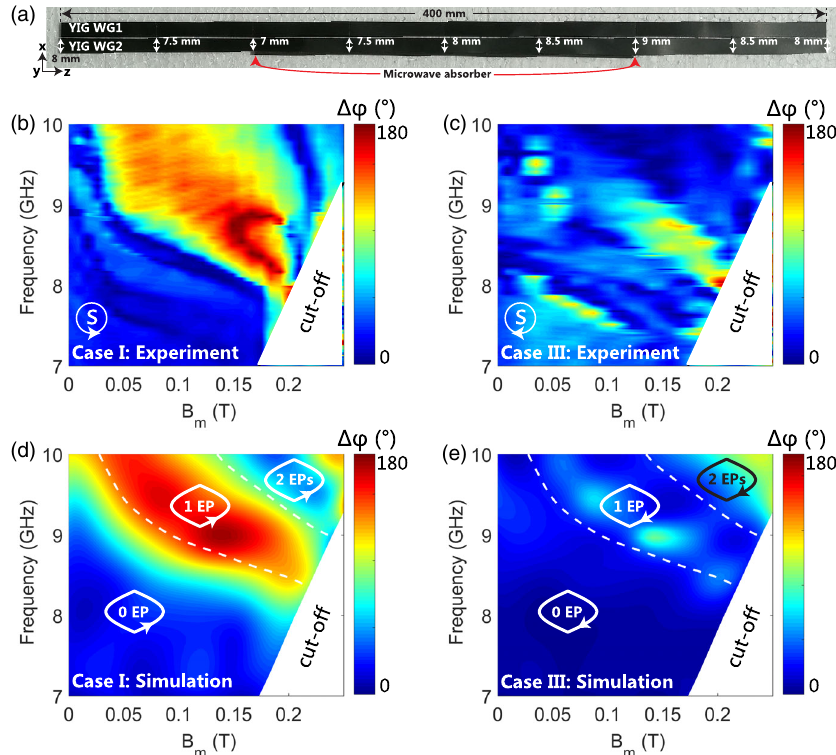
FIG. 5. (a) A photograph of the fabricated coupled YIG waveguides. Waveguide-1 measures W × H × L ¼ 8 × 4 × 400 mm, while waveguide-2 measures α ð z Þ W × H × L with the profile of α ð z Þ shown in Fig. 2(d). The gap distance is g ≈ 0 . 5 mm. Microwave absorbers with the dimensions of approximately 2 × 1 × 200 mm are attached to the side of waveguide-2 to introduce loss. (b), (c) Experimentally measured phase differences Δ φ at various bias fields B Numerically simulated phase differences Δ φ as a function of the bias field B dashed lines mark the calculated locations of EPs that partition the map into three regions depending on the number of EPs encircled. The phase difference was calculated based on the obtained transmission intensities [e.g., Δ φ ¼ 2 arctan ð T